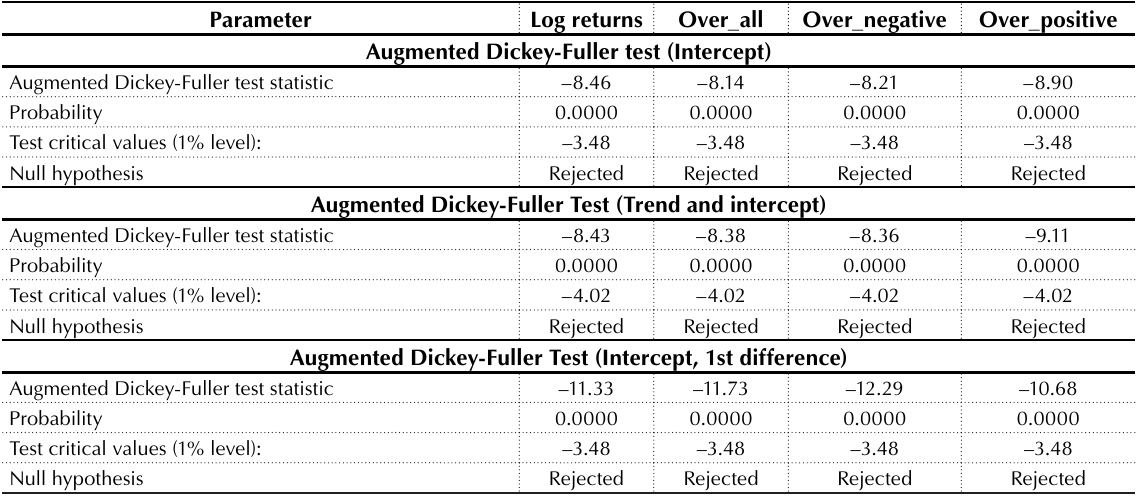
Table 4. Augmented Dickey-Fuller test: PFST index log returns and overreactions frequency data*